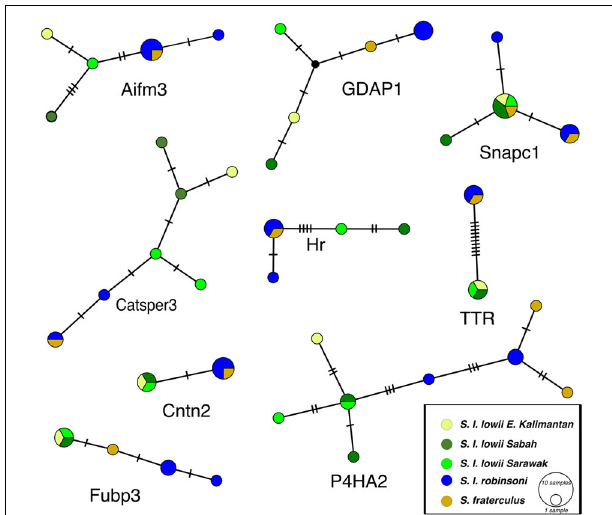
FIGURE 4 | TCS haplotype networks for each of the nine polymorphic introns studied. The size of the pie charts corresponds to the frequency of the haplotype; transversal lines represent single base pair differences; black dots represent missing haplotypes.